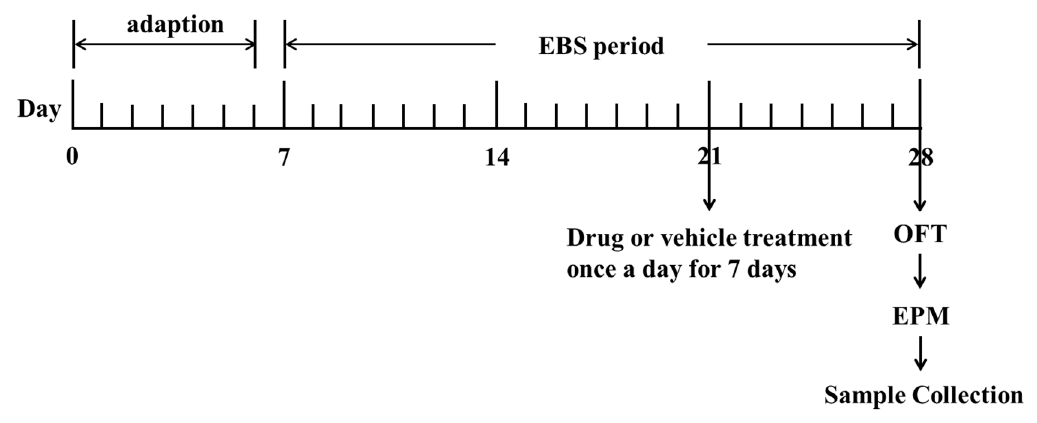
Figure 11. The flow chart of animal experiments.